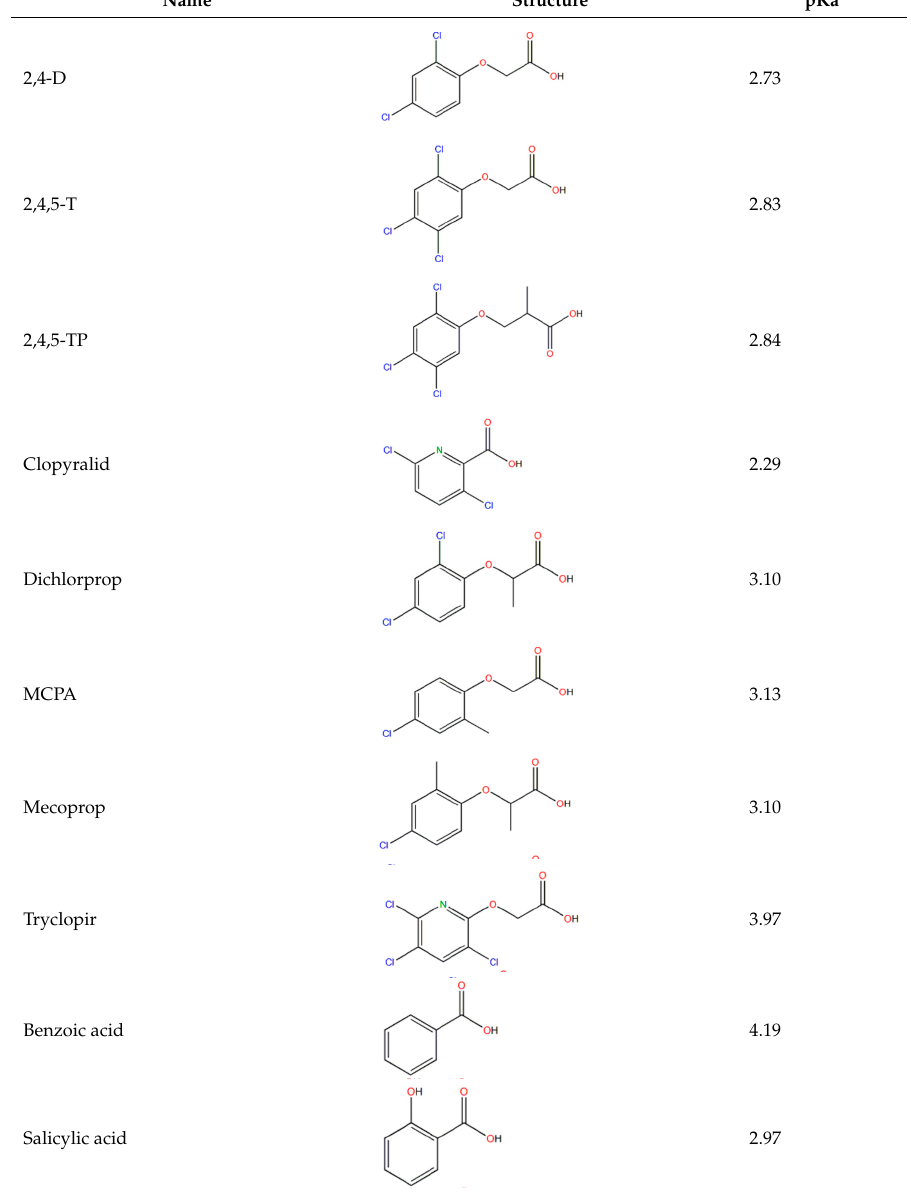
Table A1. Molecular structure and pKa value (from literature [38]) of the investigated acids.